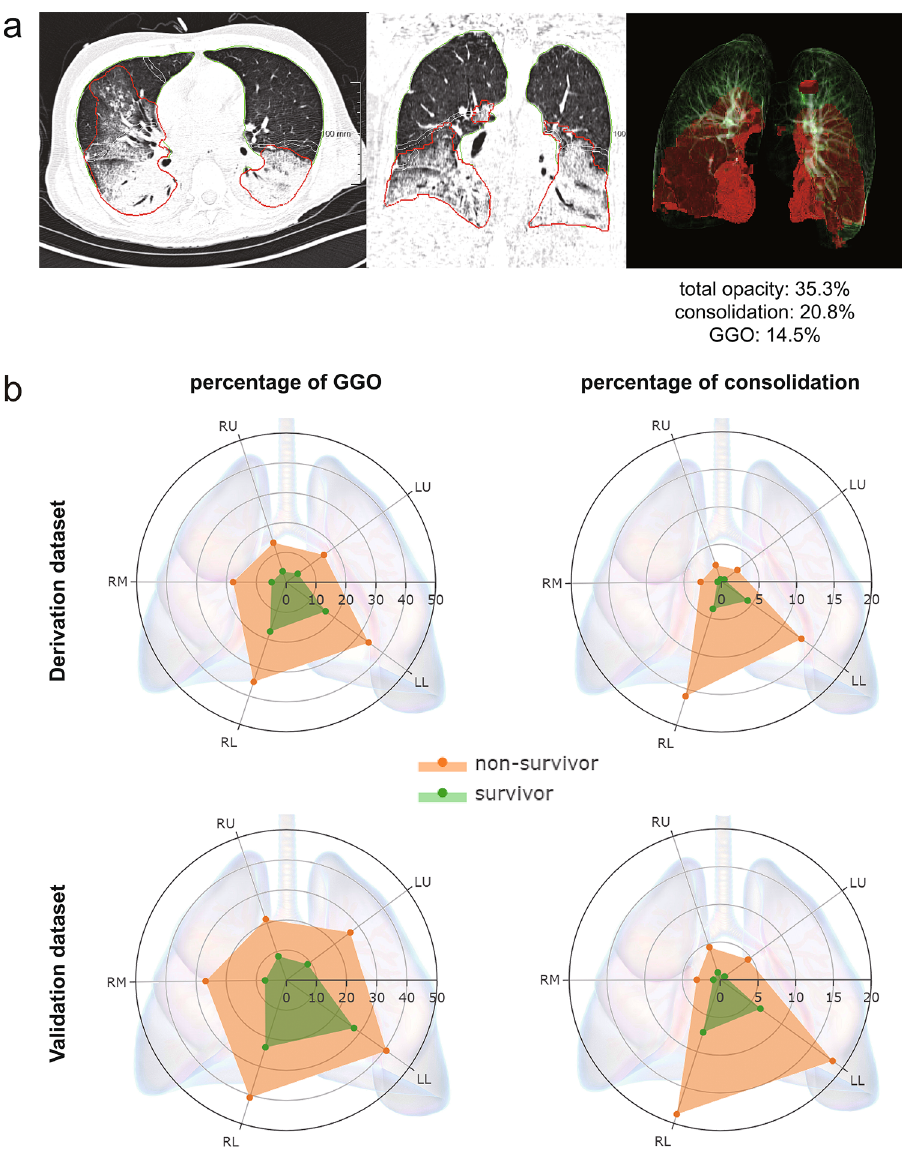
percentage of total opacity, consolidation, and ground-glass opacity (GGO) of the whole lung were automatically calculated to be 35.3%, 20.8%, and 14.5% respectively. ( b ) The average distributions of GGO and consolidation in each lobe of the lung were displayed by the radar charts in both datasets. The axial line of the radar chart referred to the mean percentage (%) of either GGO or consolidation of each lobe. RU, right upper lobe; RM, right middle lobe; RL, right lower lobe; LU, left upper lobe; LL, left lower